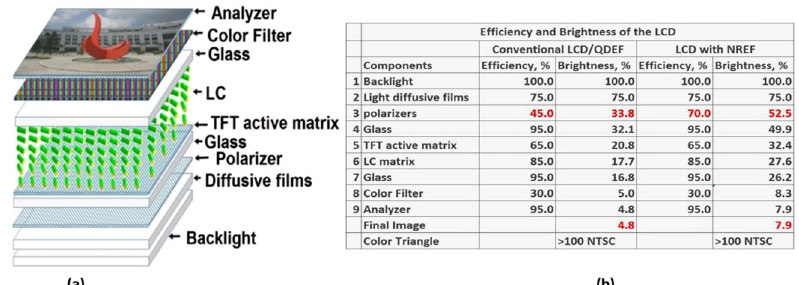
Figure 16: (a) The common LCD architecture, with an indication of the constituent elements. (b) A table listing LCD components with their optical efficiencies and brightness. Reproduced with